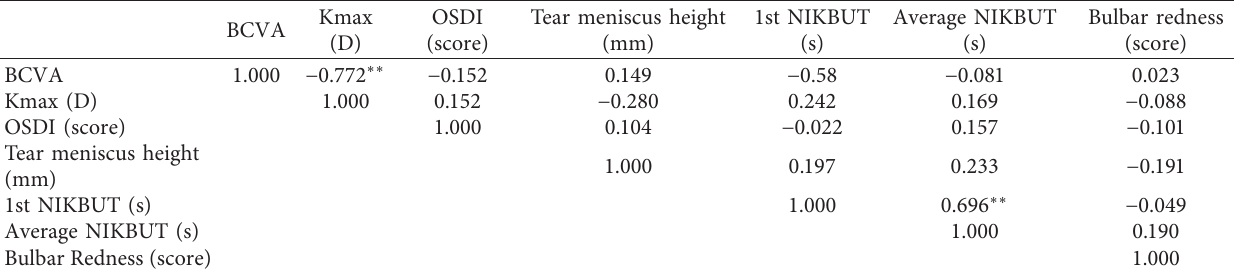
Table 5: Correlation among ocular parameters.